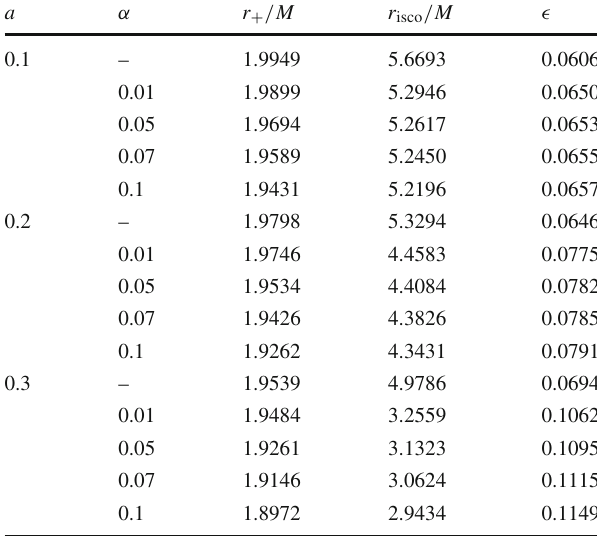
Table 1 r isco of the accretion disk and the efficiency for rotating BHs in 4 D EGB